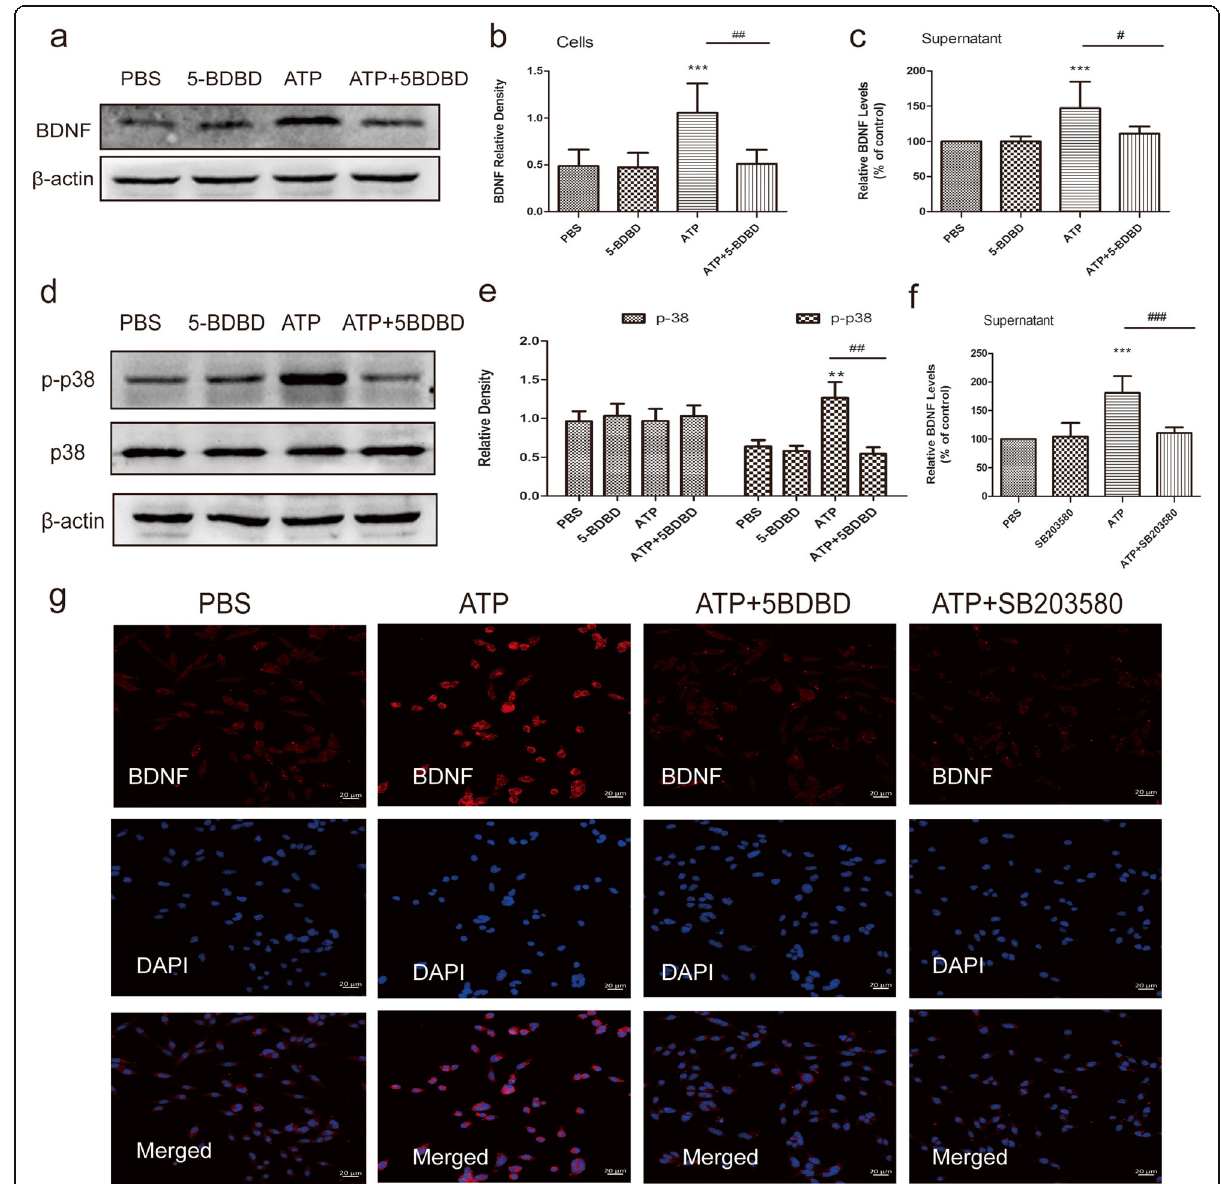
Fig. 6 Inhibition of P2X4Rs attenuates ATP-evoked release and synthesis of BDNF, which depends on p38-MAPK. a Representative Western blot results of intracellular BDNF in cells pre-incubated with 5-BDBD (20 μ M). b The histogram presents the quantitative analysis of BDNF protein. n = 6/group, One-way ANOVA, *** p < 0.001 versus PBS, ## p < 0.01 versus ATP. c Levels of BDNF in the supernatants of BV2 cells in different groups 120 min after drug treatment. n = 8/group, *** p < 0.001 versus PBS, # p < 0.05 versus NTG. d Effect of treatment with 5-BDBD on p38MAPK expression after ATP stimulation. Representative Western blot results of p38/p-p38MAPK in BV2 cells. e The histogram presents the quantitative analysis of p38/p-p38MAPK protein. n = 6/group, ** p < 0.01 versus PBS, ## p < 0.01 versus ATP. f Effect of treatment with SB203580 on BDNF release after ATP stimulation. The histogram presents the levels of BDNF in the supernatants of BV2 cells. One-way ANOVA, *** p < 0.001 versus PBS, ### p < 0.001 versus ATP. g Immunofluorescence staining for BDNF (red) in BV2 cells at 120 min after drug treatments. Scale bar = 20 μ (Fig. 9a) and thermal (Fig. 9b) hyperalgesia on days 7, 9, and Chronic ANA-12 treatment attenuates CGRP release and 11 compared with vehicle injection. However, treatment ERK phosphorylation in the TNC with ANA-12 for 11 days significantly increased the PWT According to the immunofluorescence staining results, and PWL (Fig. 9a, b). This result indicated that BDNF may chronic NTG injection increased CGRP release in the be responsible for the mechanical and thermal hyperalgesia TNC. However, ANA-12 treatment significantly reversed induced by NTG. this change (Fig. 9c, d). Furthermore, the Western blot